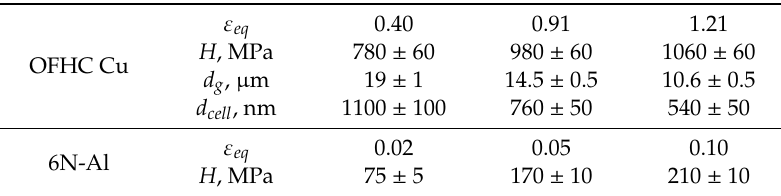
Table 3. Nanoindentation hardness, H , of OFHC Cu and 6N-Al at the di ff erent experimental HPT conditions. The mean cell and grain size of OFHC Cu are also